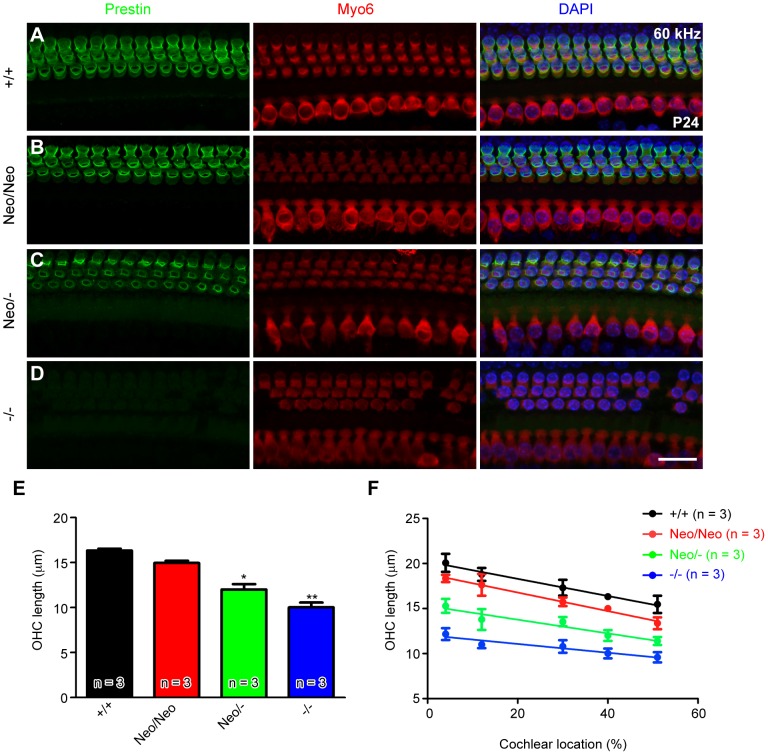
Morphological and immunohistochemical analysis of mutant mice.(A
–
D) Representative immunofluorescence staining with prestin (green) and myosin 6 (red) in whole-mount preparations of basal cochlear turns (corresponding to the 60 kHz region of the +/+ cochlea) in the indicated mouse genotypes at P24. 4′, 6-diamidino-2-phenylindole (DAPI) counterstain is shown in blue. Scale bar: 20 µm. Neo/Neo and Neo/- mice show no OHC loss or abnormal distribution of prestin. (E) Length of OHCs of each genotype at a given location corresponding to 16 kHz region of the +/+ cochlea. Values are the mean ± SEM; **: P<0.01, *: P<0.05. (F) Length of OHCs of each genotype at different locations of the cochlea. The shorter OHCs could reduce the mass of the organ of Corti and result in a higher frequency response for a given location, assuming all other material properties remain the same. The x-axis displays a normalized distance from apex (0%) to base (100%). That is, the locations responding to 4, 6, 12, 16, and 22 kHz in wild-type cochleae correspond to 4, 12, 30, 40, and 51% in a normalized distance from the cochlear apex, respectively. Calculated intercepts for each genotype differed significantly by one-way ANOVA, followed by Student's t test with a Bonferroni correction.